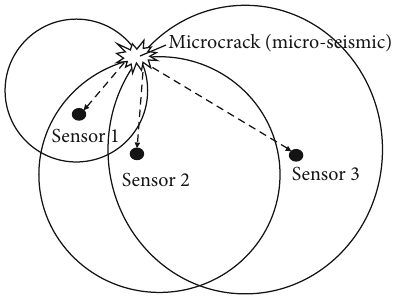
Figure 9: Location illustrative diagram of microseismic